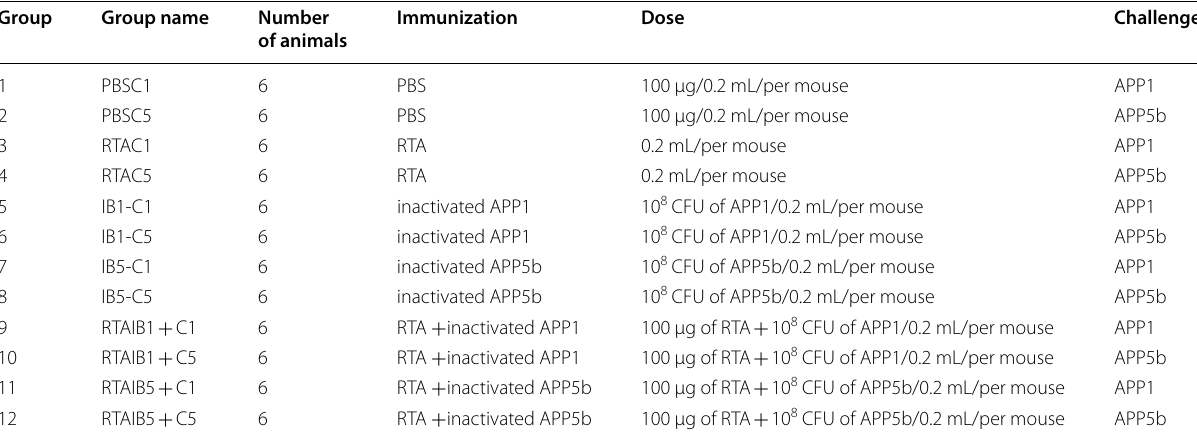
Table 1 Immunization and challenge treatment groups